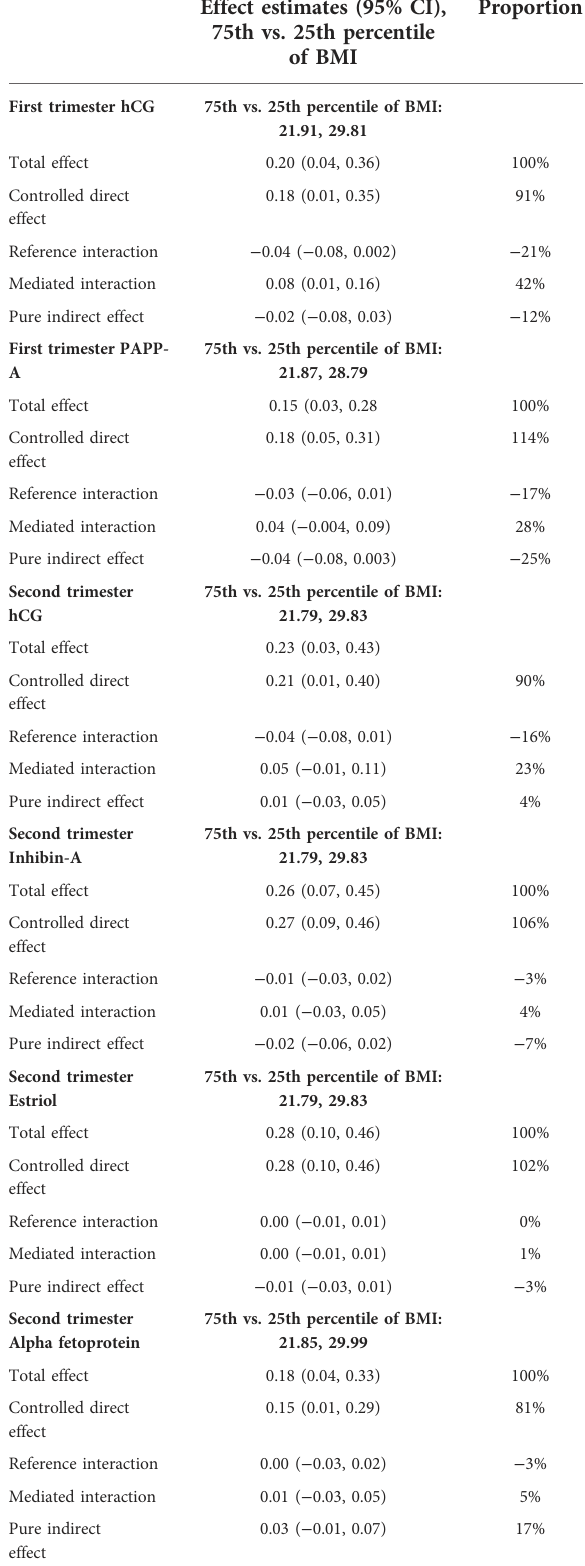
TABLE 2 Four-way decomposition of the association of maternal fi rst trimester BMI and birthweight z -scores, with circulating levels of placental-fetal proteins ( z -score) as putative